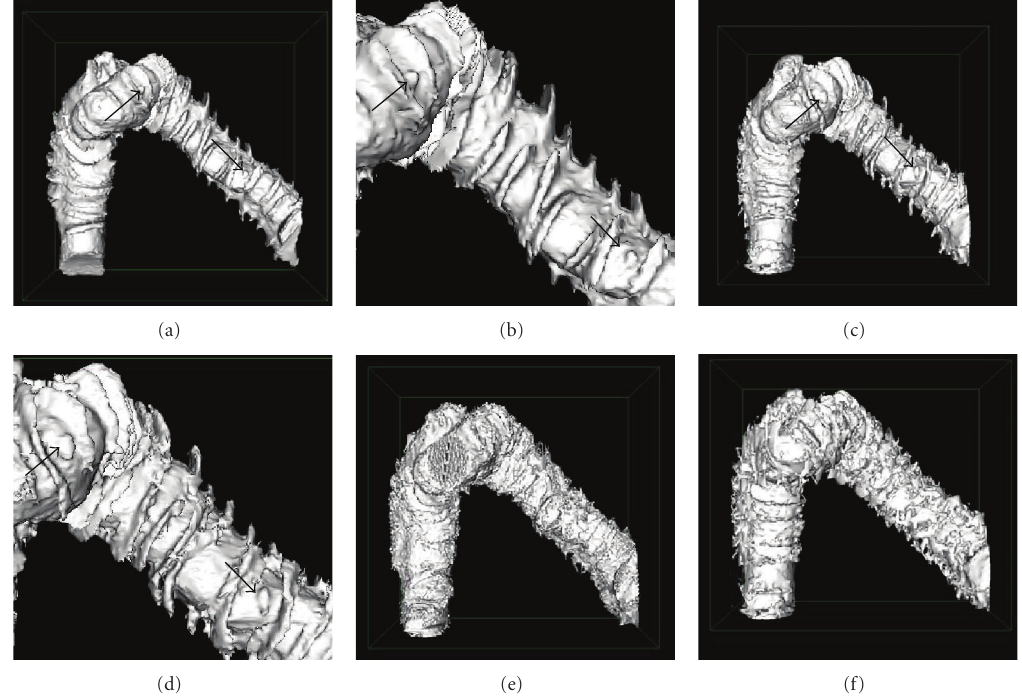
Figure 7: Digital eversion results using representative methods. (a) The centerline-based eversion using the partial-electrical-field method, (b) a magnified view of (a), (c) the surface-based eversion using the partial-electrical-field, (d) a magnified view of (b), (e) the everted mucosal surface based on the planar cross-sections orthogonal to the centerline, and (f) the mucosal surface everted along the normals of the reference